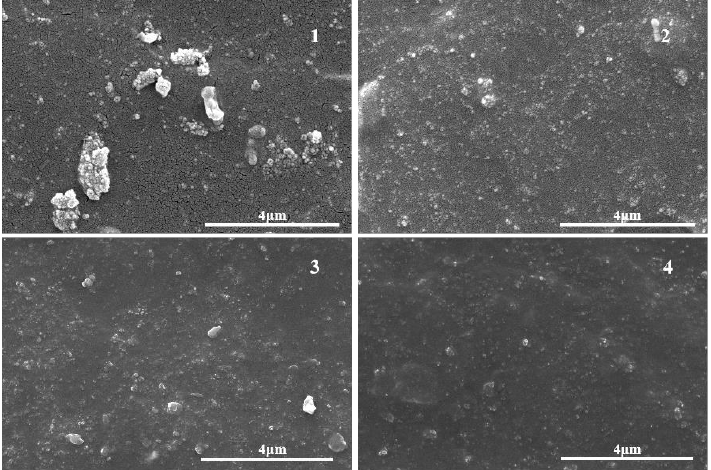
2 /EUG/SBR showed that unmodified SiO 2 formed poorly-dispersed large